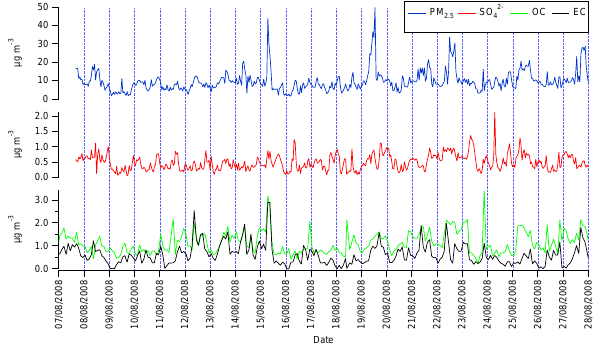
Fig. 2. Concentration-time profiles for PM ∗ carbon ∗∗ and elemental carbon ∗∗ for 7–28 August 2008. ∗ Hourly averaged mass concentration. ∗∗ Bihourly averaged mass concen-